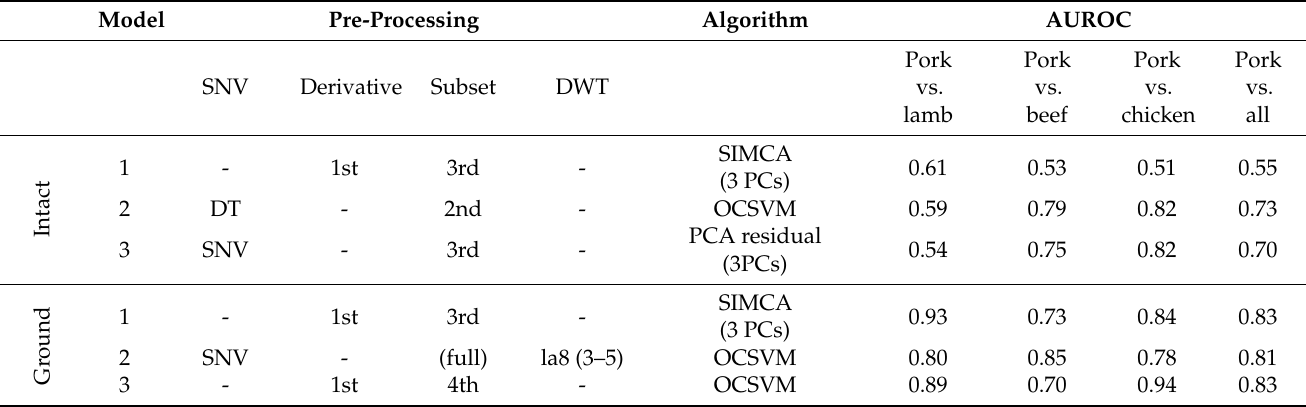
Table 1. Details and AUROCs on the manually picked models for the NIR sensor.